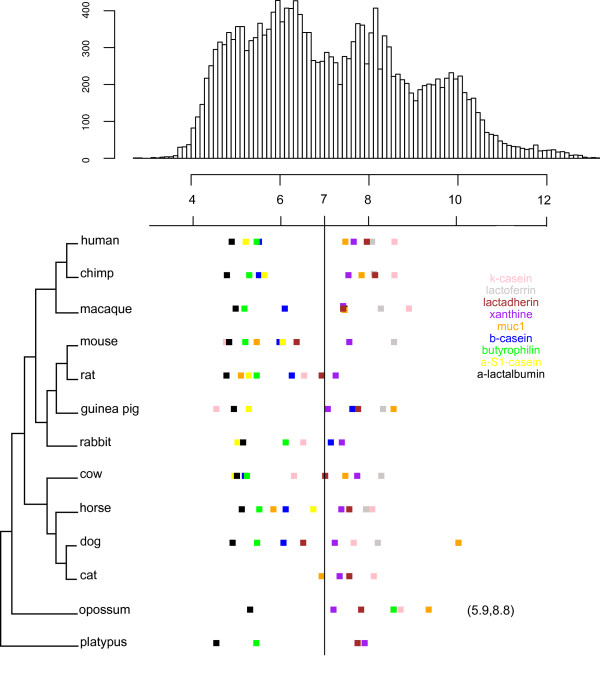
pI values for the nine major milk proteins in 13 mammalian species compared to the pI of the human proteome. The top histogram represents the pI distribution of the human proteome. The histogram's x-axis is shared with that of the major milk proteins' pI shown below. The Colors indicate the different milk proteins. The tree on the left is the mammalian species tree from Benton and Donoghue [23]. Two extra pI values are represented between brackets at the opossum level, these represent the pI of the reported extra copies of κ-casein this species possess [6]. The values are for the proteins with the accession numbers FJ548612 and FJ548626 respectively.